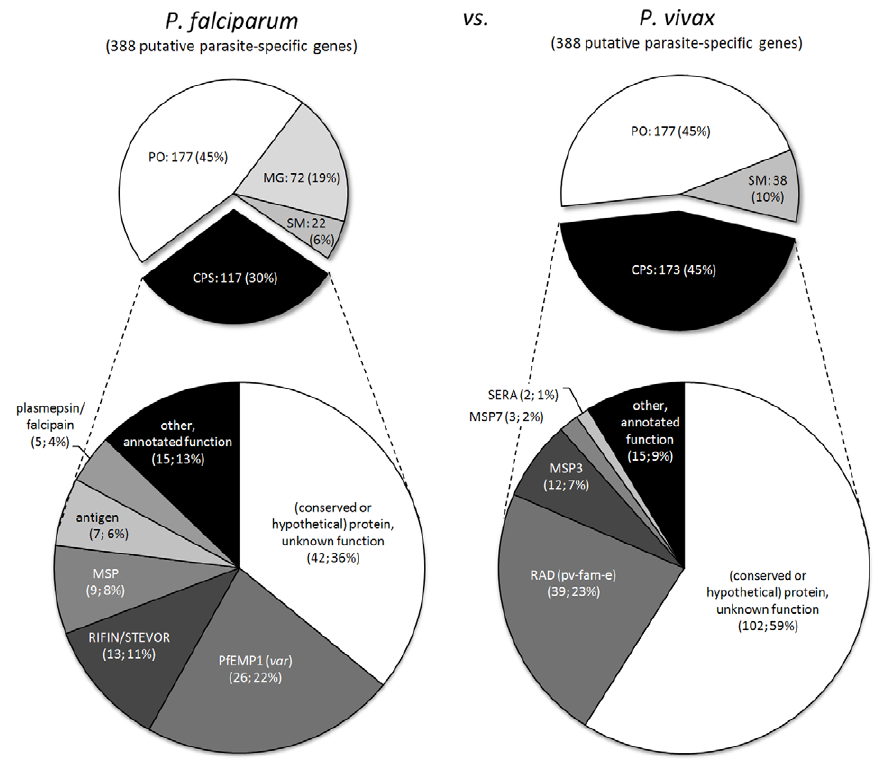
Figure 6. P.falciparum -specific genes in chromosome-internal regions enriched with virulence genes. Putative parasite-specific genes identified at SGRs and SBRs between P. falciparum (388 genes) and P. vivax (388 genes) were examined within their syntenic context (upper two diagrams). Differences considered as non-reliable were excluded from further analysis, including positional orthologs (PO), potential missing genes (MG), and potential split or merged genes (SM). Confirmed parasite-specific (CPS) genes were examined for annotated functions (lower two diagrams). P. falciparum -specific genes (lower left diagram) were found to be enriched (FDR-adjusted p-value , 0.05) for known virulence factors with associated GO biological processes pathogenesis (GO:0009405), adhesion to host (GO:0044406), cell adhesion (GO:0007155), and defense response (GO:0006952), suggesting potential virulence-associated functions for genes currently not implicated in human virulence.